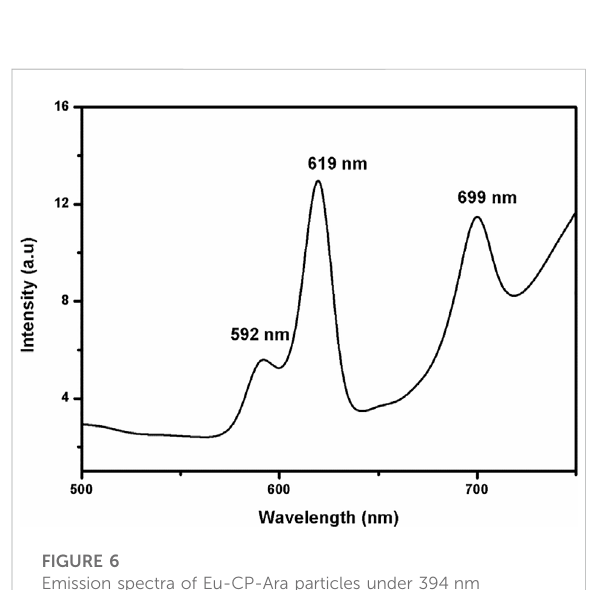
(Figure 1F) gand RPMI-1640 medium (Figures 1H,I). After 6 days, the dispersed solution was still very stable (Figures 1F – I).